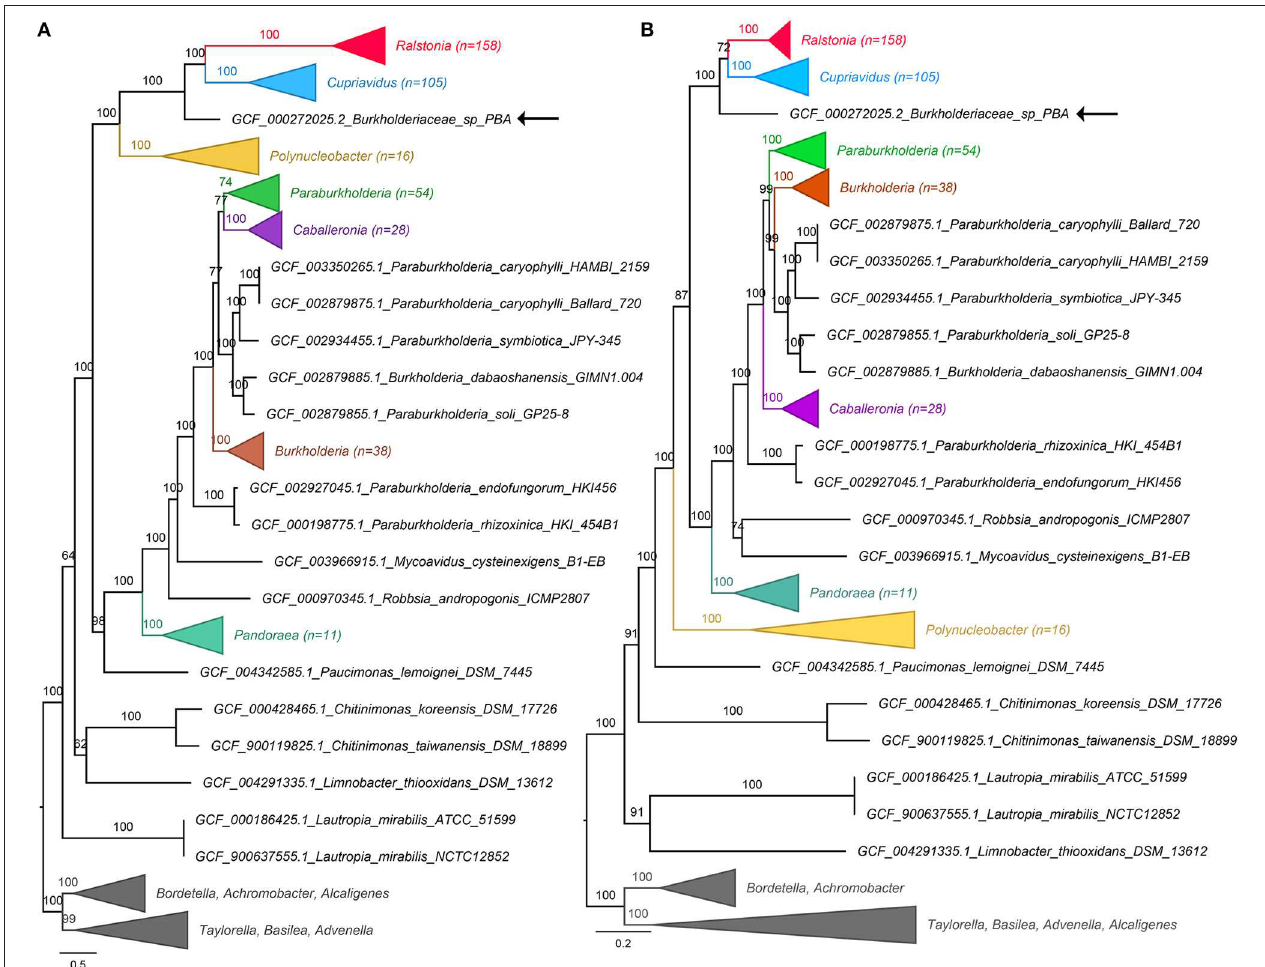
FIGURE 1 | Genome-based phylogeny of Burkholderiaceae. Construction of the phylogenomic trees used protein alignments generated from (A) PhyloPhlAN and (B) GToTree. Numbers in brackets indicate number of taxa in the collapsed clades. GCF codes preceding the species names are RefSeq Assembly numbers. The positions of strain PBA in both trees are shown by black arrows. Branch lengths and labels indicate the number of substitutions per site and IQTree ultrafast bootstrap support values, respectively. The uncollapsed trees are available in the Zenodo database